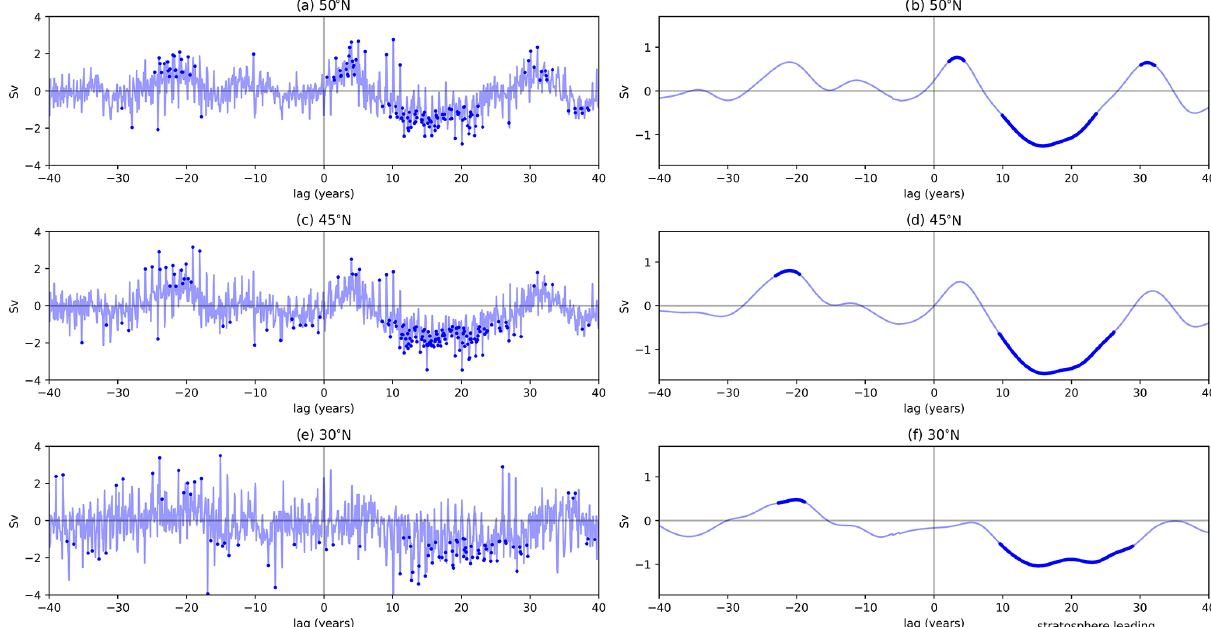
Figure 3. Lagged response of the AMOC index to persistent NAM 10 intervals. Blue time series shows AMOC composite difference values between positive and negative NAM 10 intervals defined in Sect. 2.4. The x axis denotes the lead (negative values) or lag (positive values) relative to the interval’s central year. Solid blue dots denote composite differences significant at the 95% level under a two-tailed Student’s t test. Panels (a) , (c) , and (e) show monthly AMOC composites, while panels (b) , (d) , and (f) show smoothed AMOC composites, using a Gaussian filter ( σ = 2